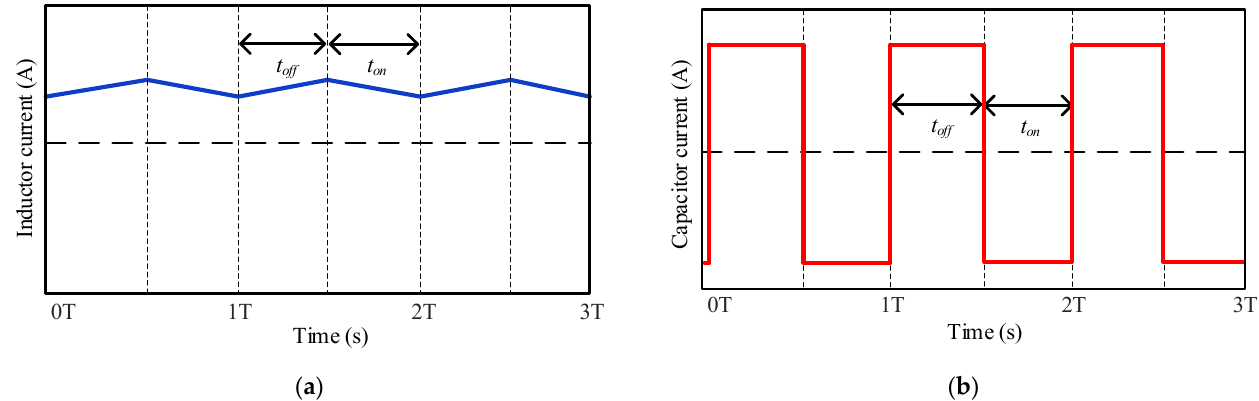
Figure 5. Proposed DPP topology ( a ) General circuit, ( b ) Energizing state/mode 1: power flow when SM2 is producing more than SM1 , ( c ) De-energizing state/mode 2: power flow when SM2 is producing more than SM1 . Here, L and C are switched-inductor and switched-capacitor used for the mismatch energy processing. I S 1 and I S 2 are the currents flowing through the switches Q 1 , Q 2 , Q 3 , and Q 4 .